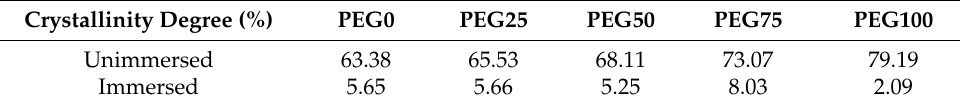
Table 1. The crystallinity of samples before and after seawater immersion.